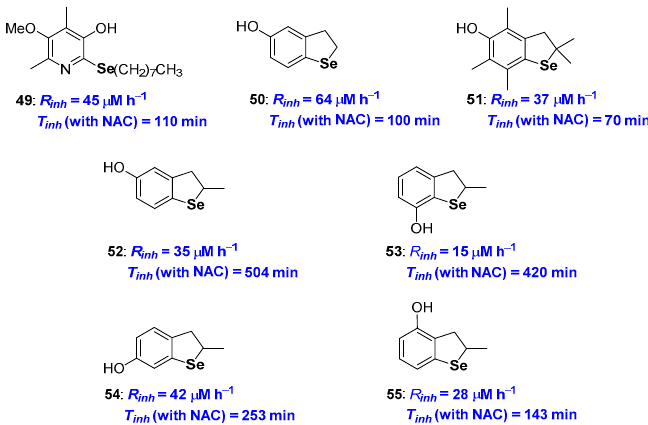
Figure 14. A selection of Selenium containing phenols prepared so far.